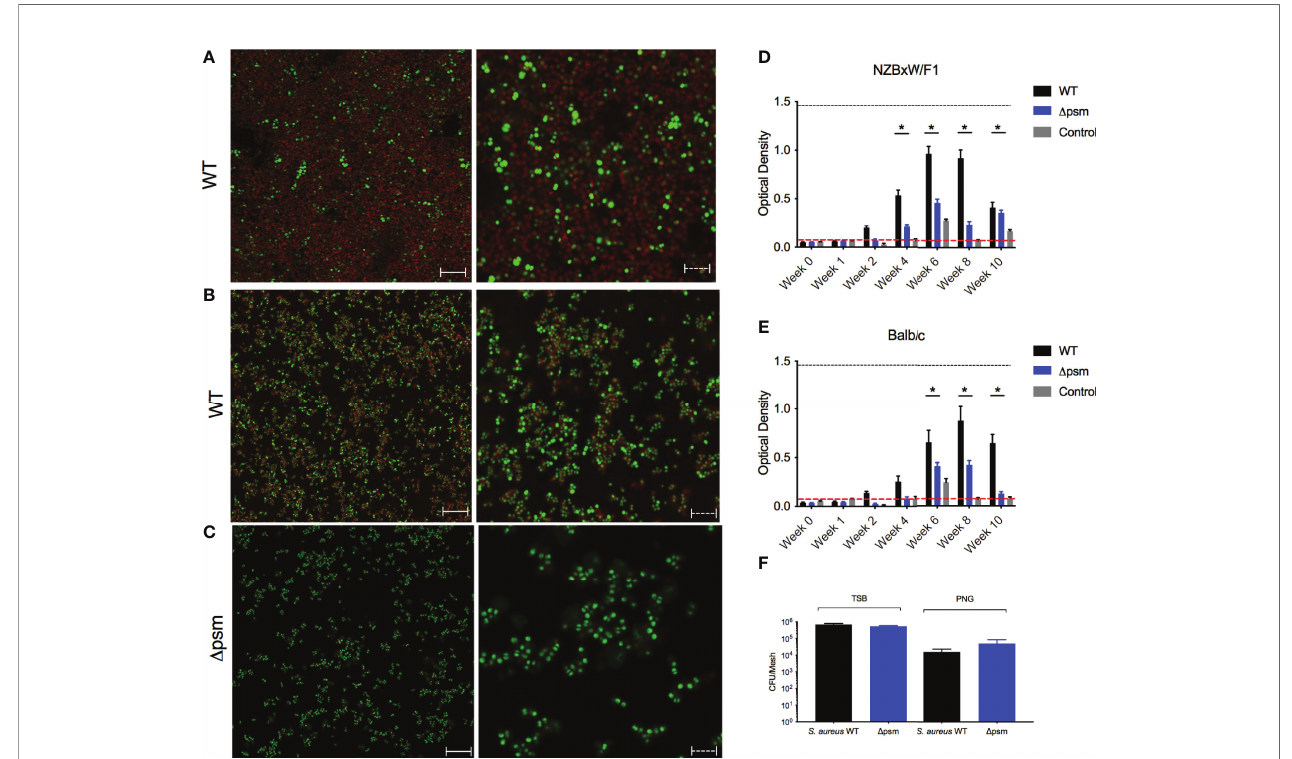
FIGURE 4 | S. aureus- colonized mesh implantation induces autoantibody production. To determine the expression of PSM amyloids, Confocal Laser Scanning Microscopy (CLSM) images of in vitro bio fi lms of S. aureus ( A ) SH1000 (WT) and (C) D psm SH1000 stained with syto9 (green) and Congo red (red); or (B) SH1000 (WT) stained with syto9 (green) and amyloid-speci fi c dye 1-Fluoro-2,5-bis[(E)-3-carboxy-4-hydroxystyryl]benzene (FSB). Bio fi lms visualized at 100x, solid scale bar represents 50µM and dashed scale bar represents 5µM. S. aureus WT (black bars) or D psm (blue bars) bio fi lm-colonized mesh or control mesh was implanted subcutaneously into the back fl anks of (D) NZBxW/F1 or (E) Balb/c mice. Blood was collected via tail bleeding every week and sampled for production of dsDNA autoantibodies (optical density 650-405nm). Black dotted line represents the maximum autoantibody production of positive control sera and the red dotted line represents autoantibody detection in naïve serum. Mean and SEM graphed; signi fi cance was calculated using a 2-way ANOVA and Tukey ’ s multiple comparisons tests (*, P < 0.05). (F) Bio fi lms of S. aureus SH1000 wildtype (WT) (black bar) or D psm mutant (blue bars) were grown on mesh in either tryptic soy broth or peptone- based media (PNG) for 48 hours at 37°C. Bio fi lms were sonicated and the recovered bacteria were enumerated as colony forming units. Mean and SEM graphed; signi fi cance was calculated using a 1-way ANOVA and multiple comparisons tests. No statistical signi fi cance was